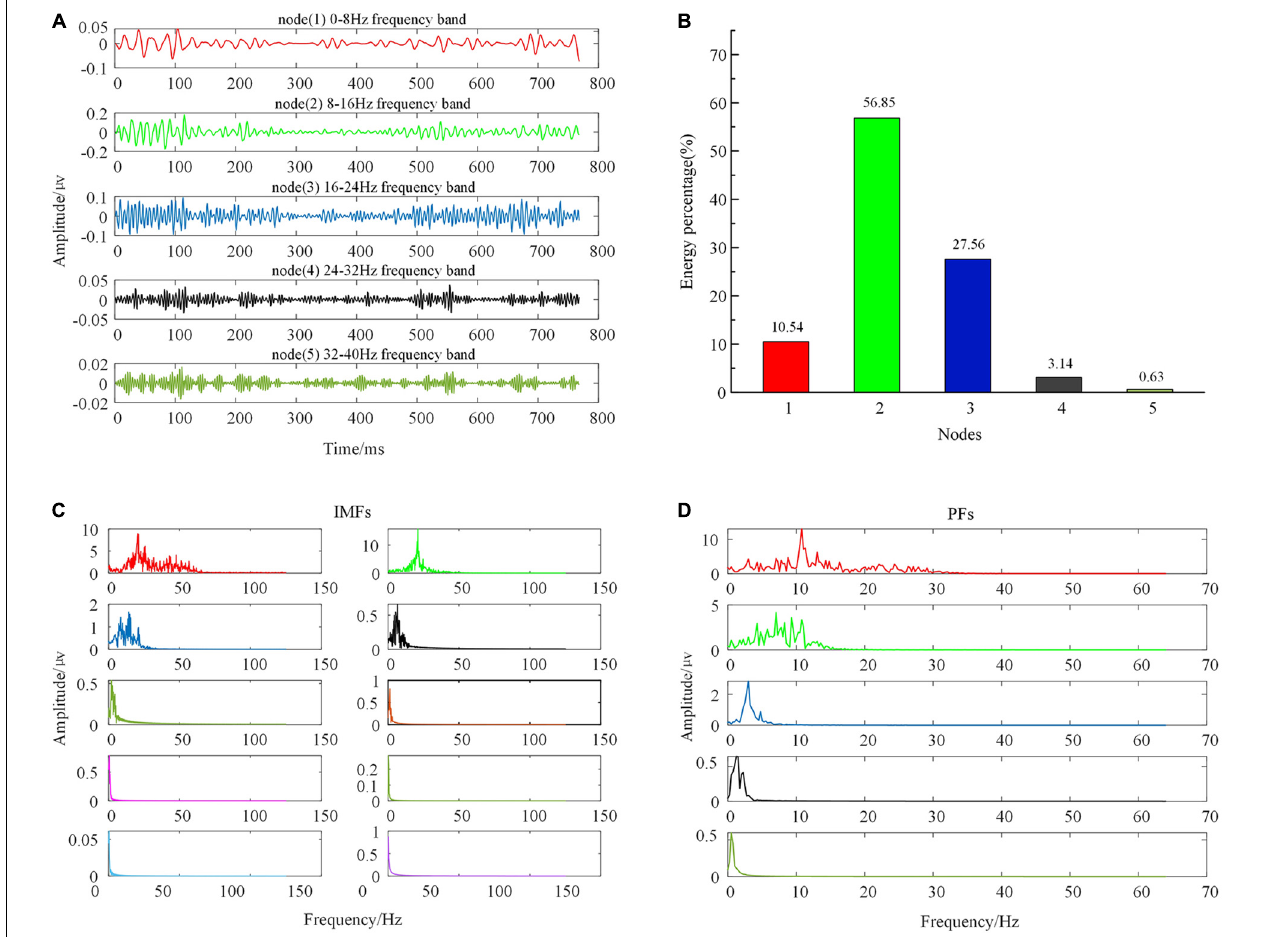
FIGURE 2 | Time domain, frequency spectrum, and energy ratio diagram of each component of EEG signal after TFD. (A) EEG waveform of the first 5 nodes of layer 3 after WPT; (B) EEG energy ratio diagrams of the first 5 nodes of layer 3 after WPT; (C) Spectrum diagram of each IMF component after FEEMD; (D) Spectrum diagram of each PF component after